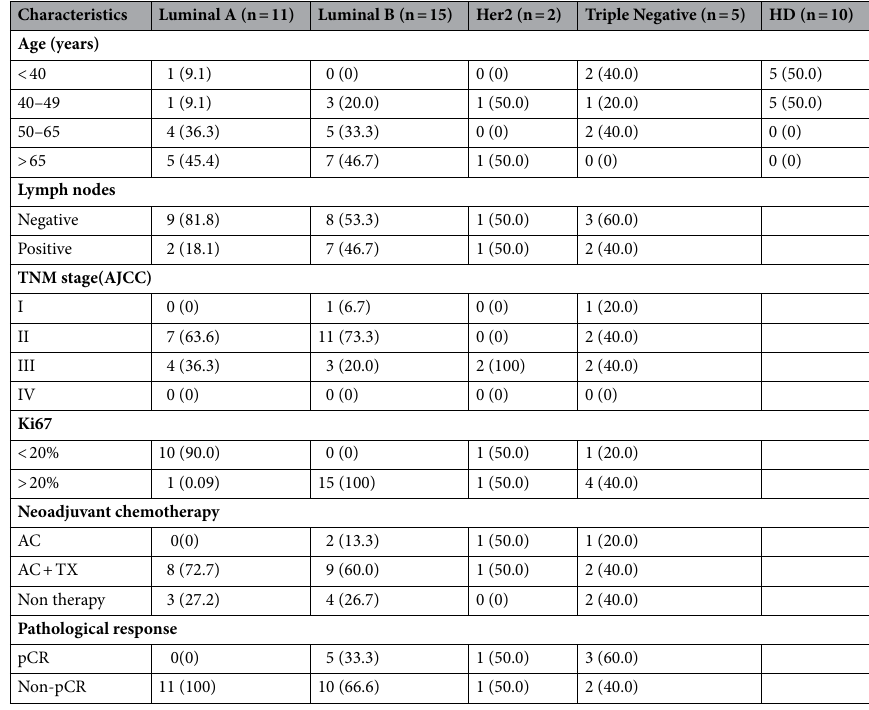
Table 1. Clinicopathological characteristics of patients with breast cancer. HER2, human epidermal growth factor receptor 2; AC, Anthracyclines-Cyclophosphamide; TX, taxane; pCR, pathological complete response; Non-pCR, non